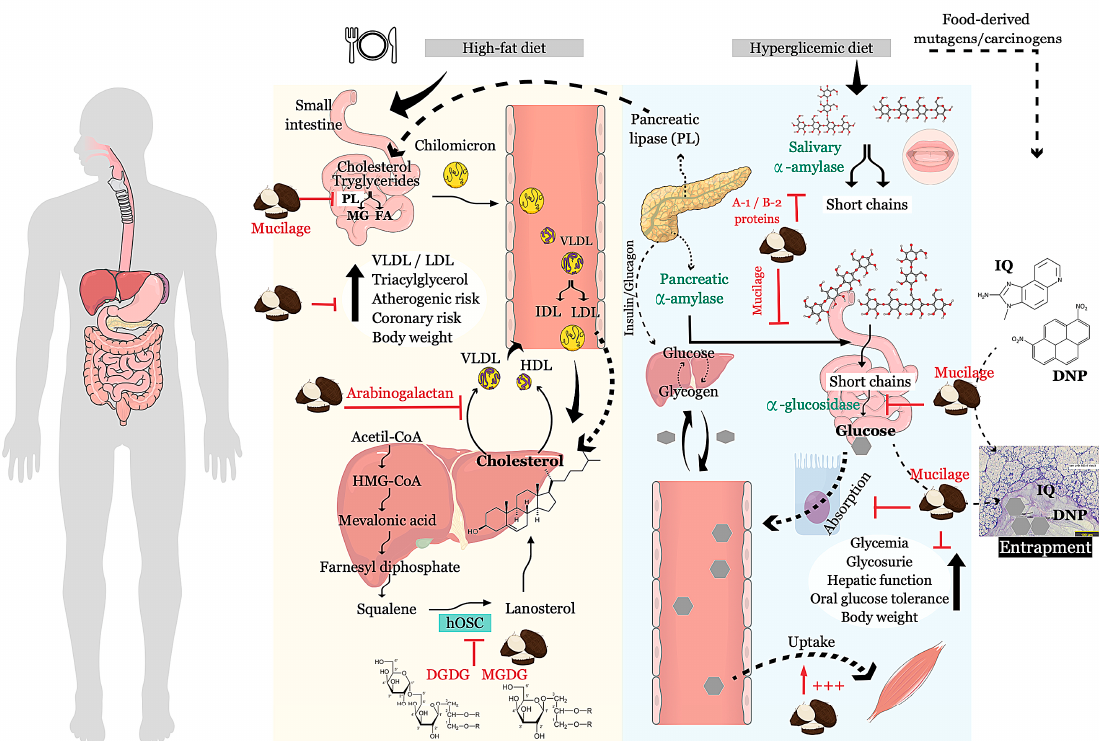
Figure 3. Putative targets of taro-derived components in metabolic pathways. Lipid and carbohydrate metabolisms can be modulated, mainly, by taro mucilage, arabinogalactan, monogalactosyldiacylglycerols (MGDG), digalactosyldiacylglycerols (DGDG) and A-1/B-2 proteins, which may act in conjunction to control glycemia, lipidemia, and downstream effects such as body weight, glucose tolerance, and glycosuria, hepatic function, atherogenesis, and coronary risk. Inhibition of human lanosterol synthase (hOSC) affects the cholesterol synthesis of pancreatic lipase (PL), reducing triacylglyceride hydrolysis to monoglycerides (MG) and free fatty acids (FA), down-regulation of salivary α -amylase, glucose release by α -glucosidase, glucose absorption, reduction of very low-density lipoprotein (VLDL) formation, and enhancement of muscle glucose uptake. Mucilage can entrap mutagenic/carcinogenic agents, 1,8 dinitropyrene (DNP) and heterocyclic amine 2-amino-3-methylimidazo[4,5-f] quinoline (IQ), avoiding their absorption and consequent effects. HMG-CoA— β -Hydroxy β -methylglutaryl-Coenzyme A; IDL—intermediate-density